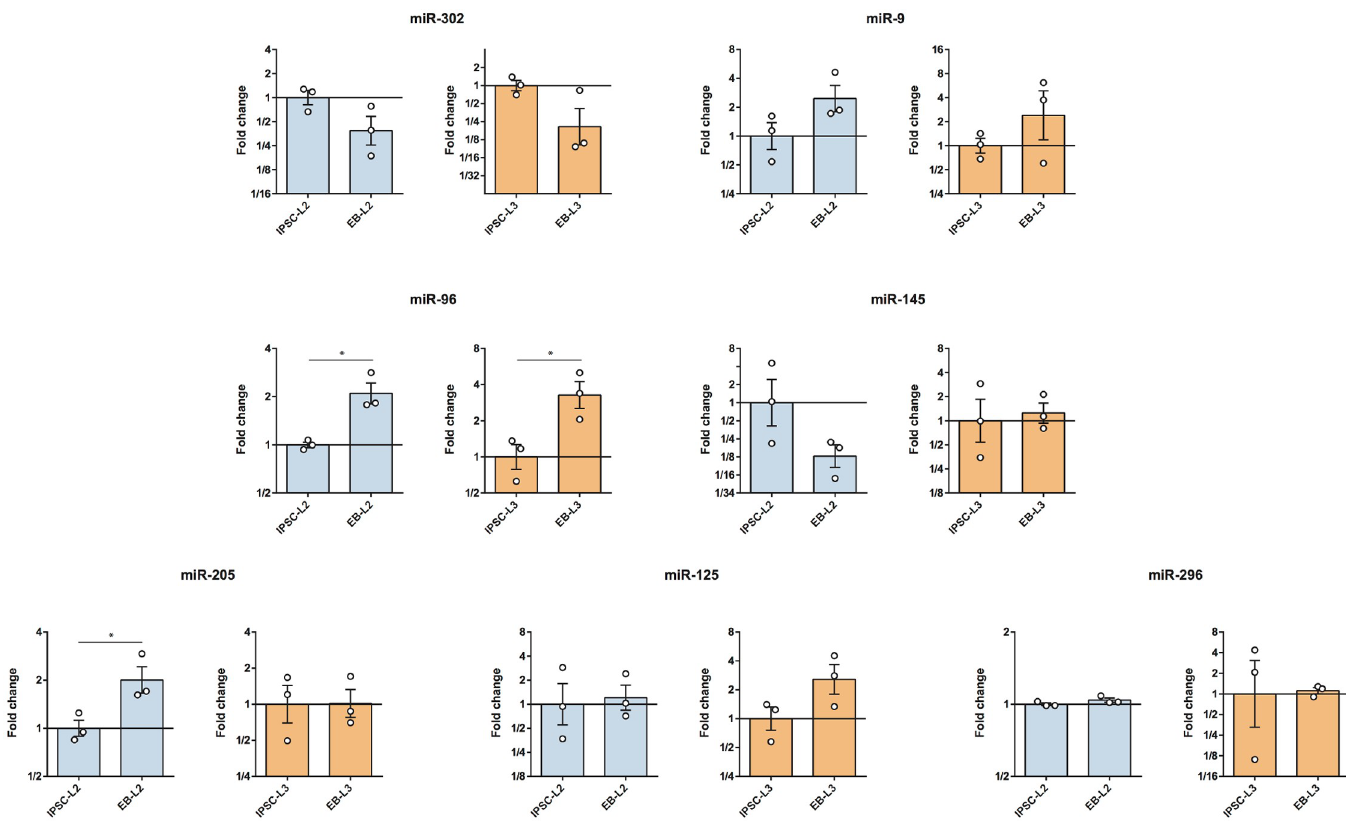
Fig 5. RT-qPCR analysis of 7 microRNAs in the iPSCs lines and the embryo bodies (EBs) derived from them, iPSC-L2 vs. EB-L2 and iPSC-L3 vs. EB-L3. Results are presented as means ± SEM (n = 3). EB-L2 data were relativized to iPSC-L2 data and EB-L3 data were relativized to iPSC-L3 data. � Statistically different (p < 0.05).